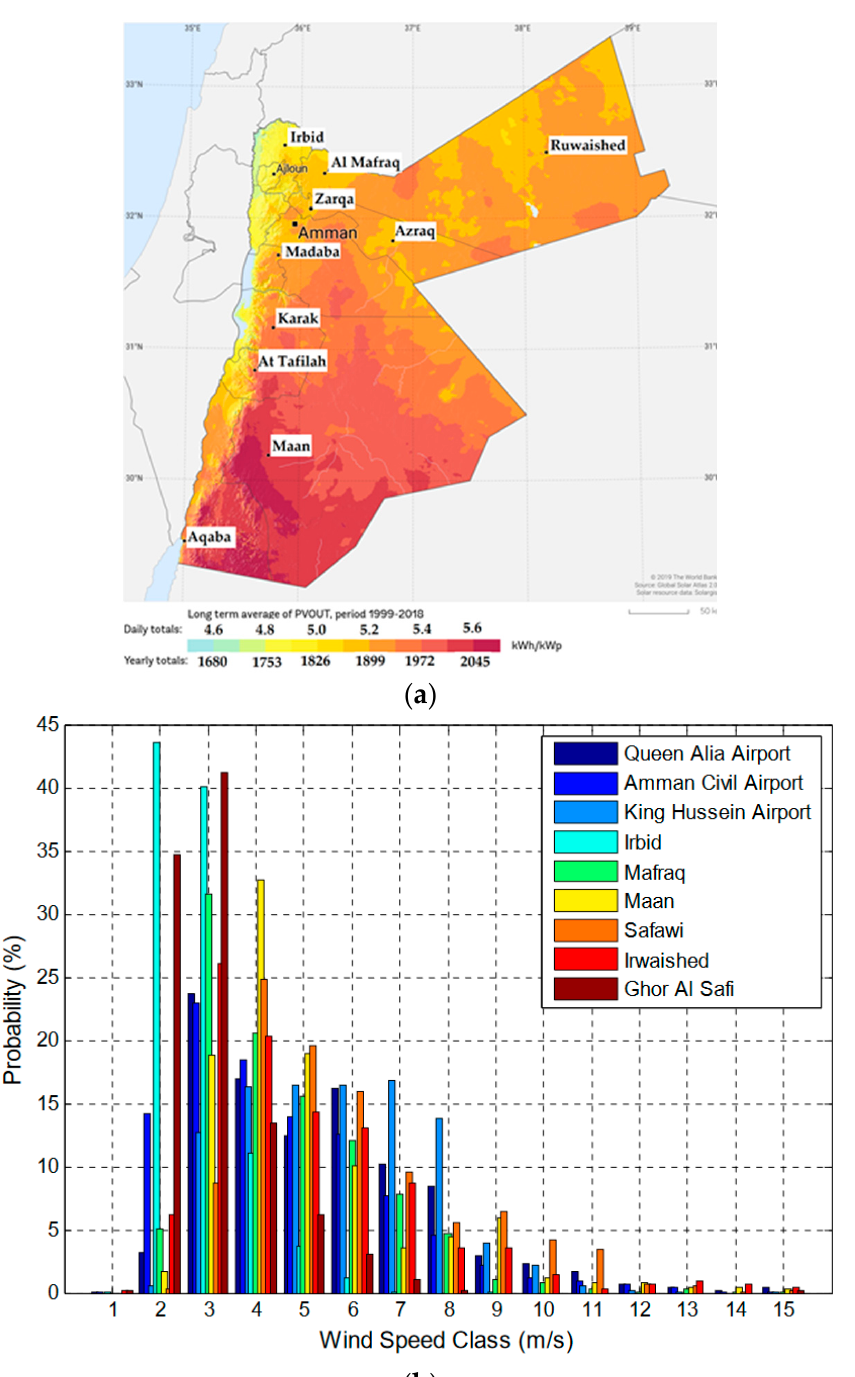
Figure 4. PV power potential ( a ) [28] and wind speed probability ( b ) [29] in Jordan.